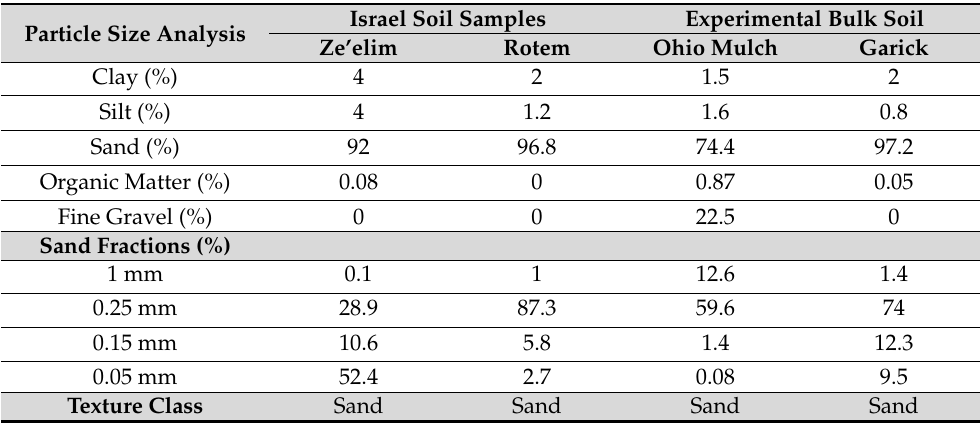
Table 2. Particle Size Distribution of Different